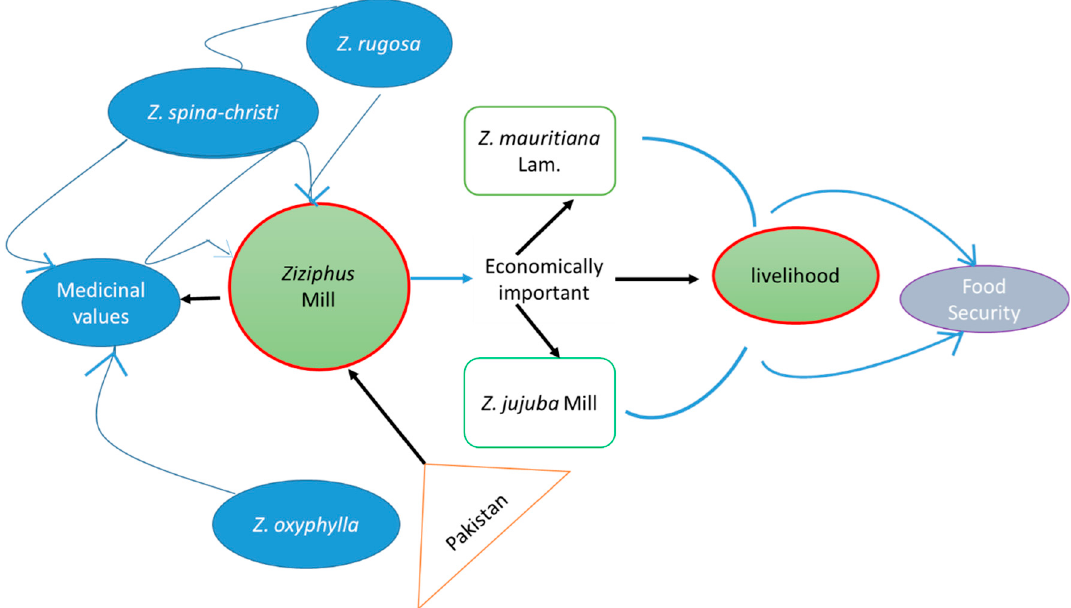
Figure 5. The representation of the Ziziphus species in Pakistan and the potential role in human life and livelihood in the arid and semi-arid regions of Pakistan.